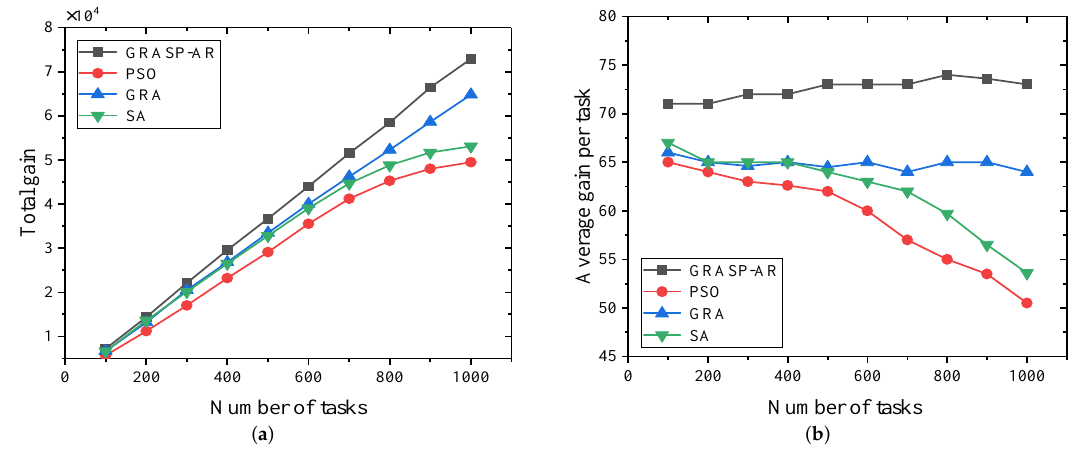
Figure 7. Effectiveness and efficiency of various parameter combinations for GRASP-AR. ( a ) The total gain achieved for all tasks vs. the number of tasks available. ( b ) The average gain achieved per task vs. the number of tasks